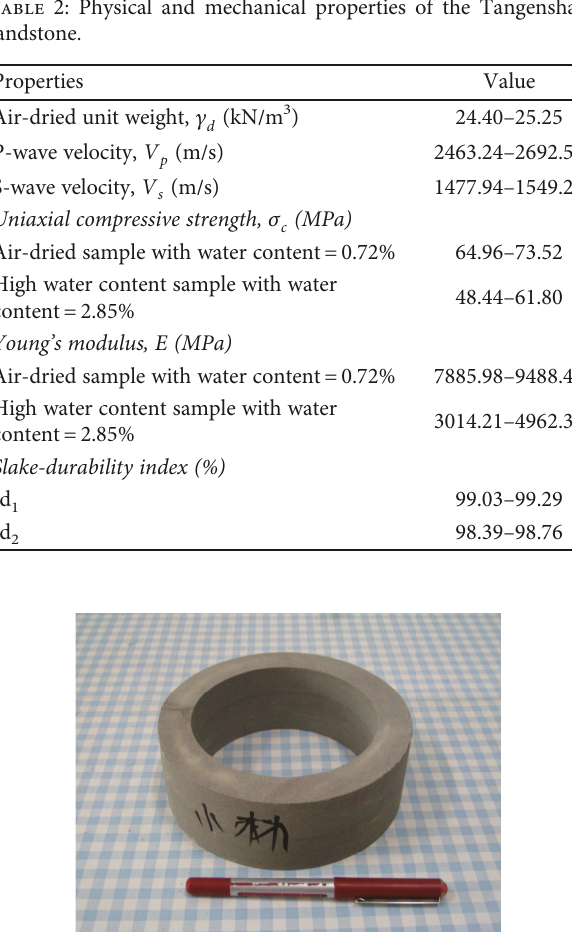
Figure 6: Hollow cylinder sample of the Tangenshan sandstone.